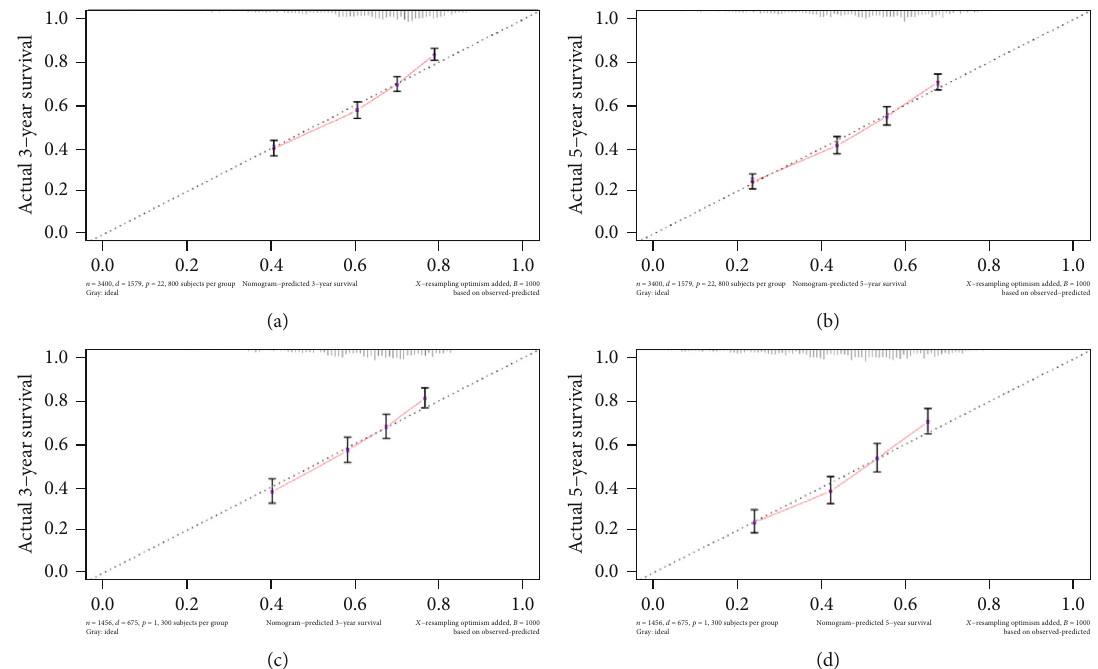
Figure 5: Calibration plot of the nomogram in the derivation cohort and validation cohort. The x -axis is the predicted survival calculated by the nomogram, and the y -axis is the actual survival estimated by the Kaplan-Meier